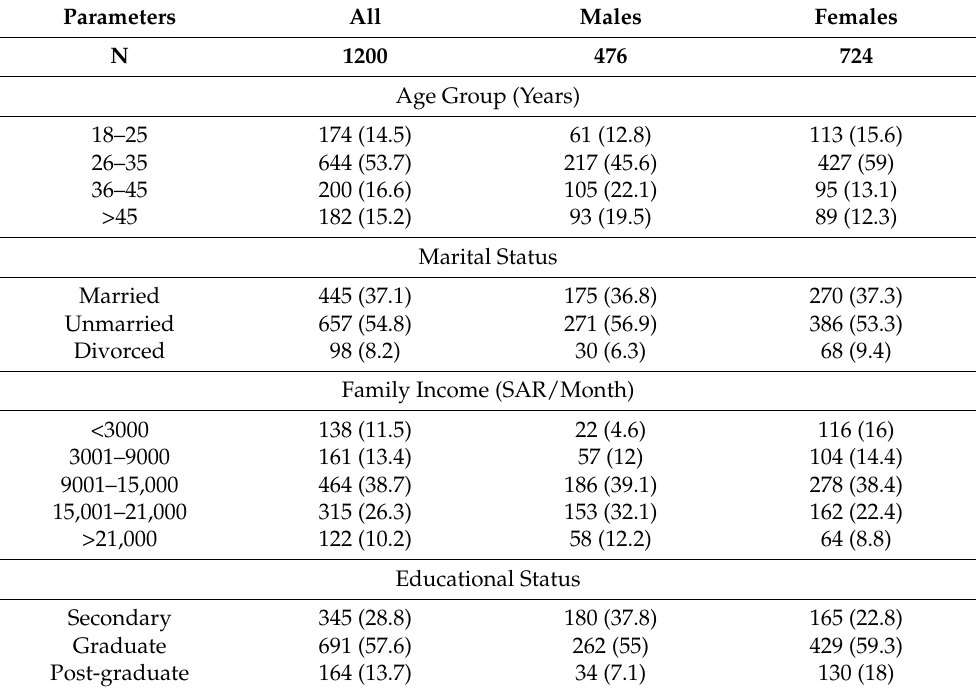
Table 1. Socio-demographic characteristics of the study